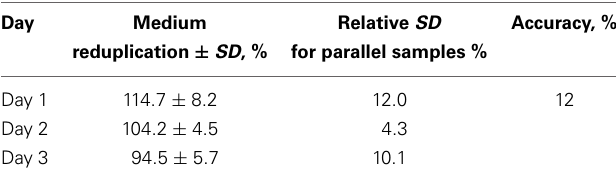
Table 5 | Intralaboratory precision and reduplication of the method.